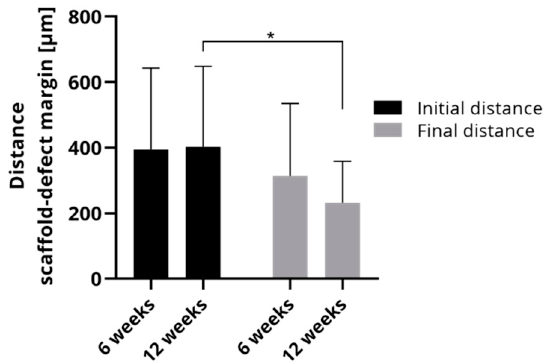
Figure 7. Average of initial and final distance of scaffold and defect margin of rats which were investigated either after 6 weeks or after 12 weeks (mean ± SD, * p < 0.05, n = 20 and n = 25 for 6 and 12 weeks, respectively).